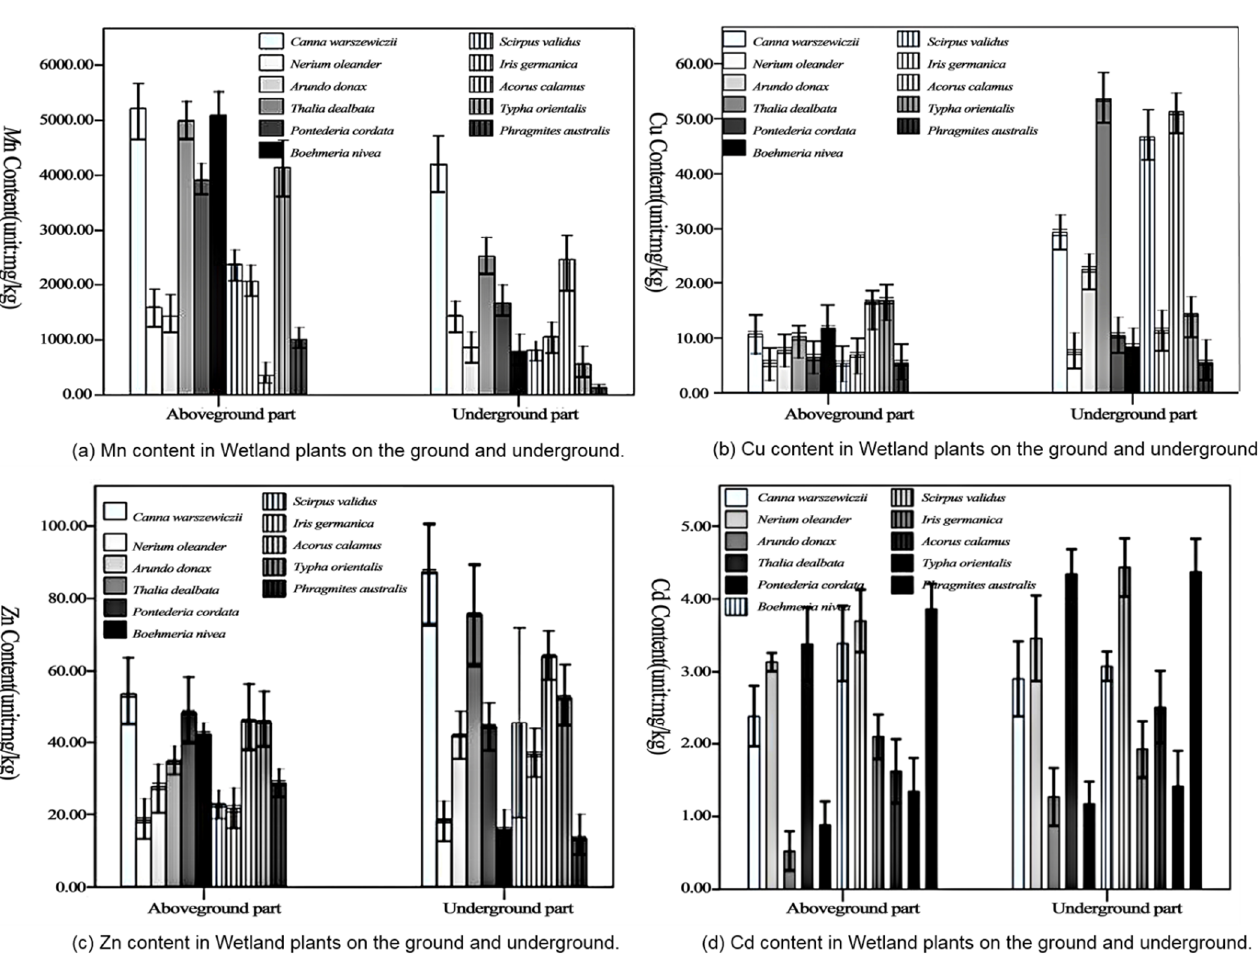
Figure 6. The accumulation of heavy metal content in Wetland plants on the ground and underground.